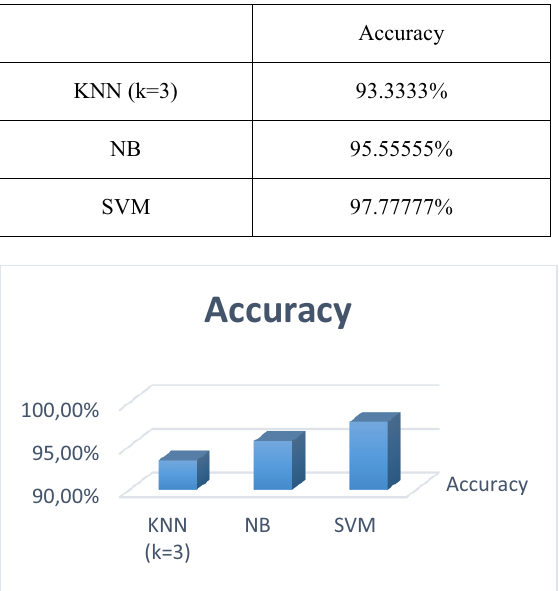
Table 3. Accuracy rate of attacks (UNSW-NB15)